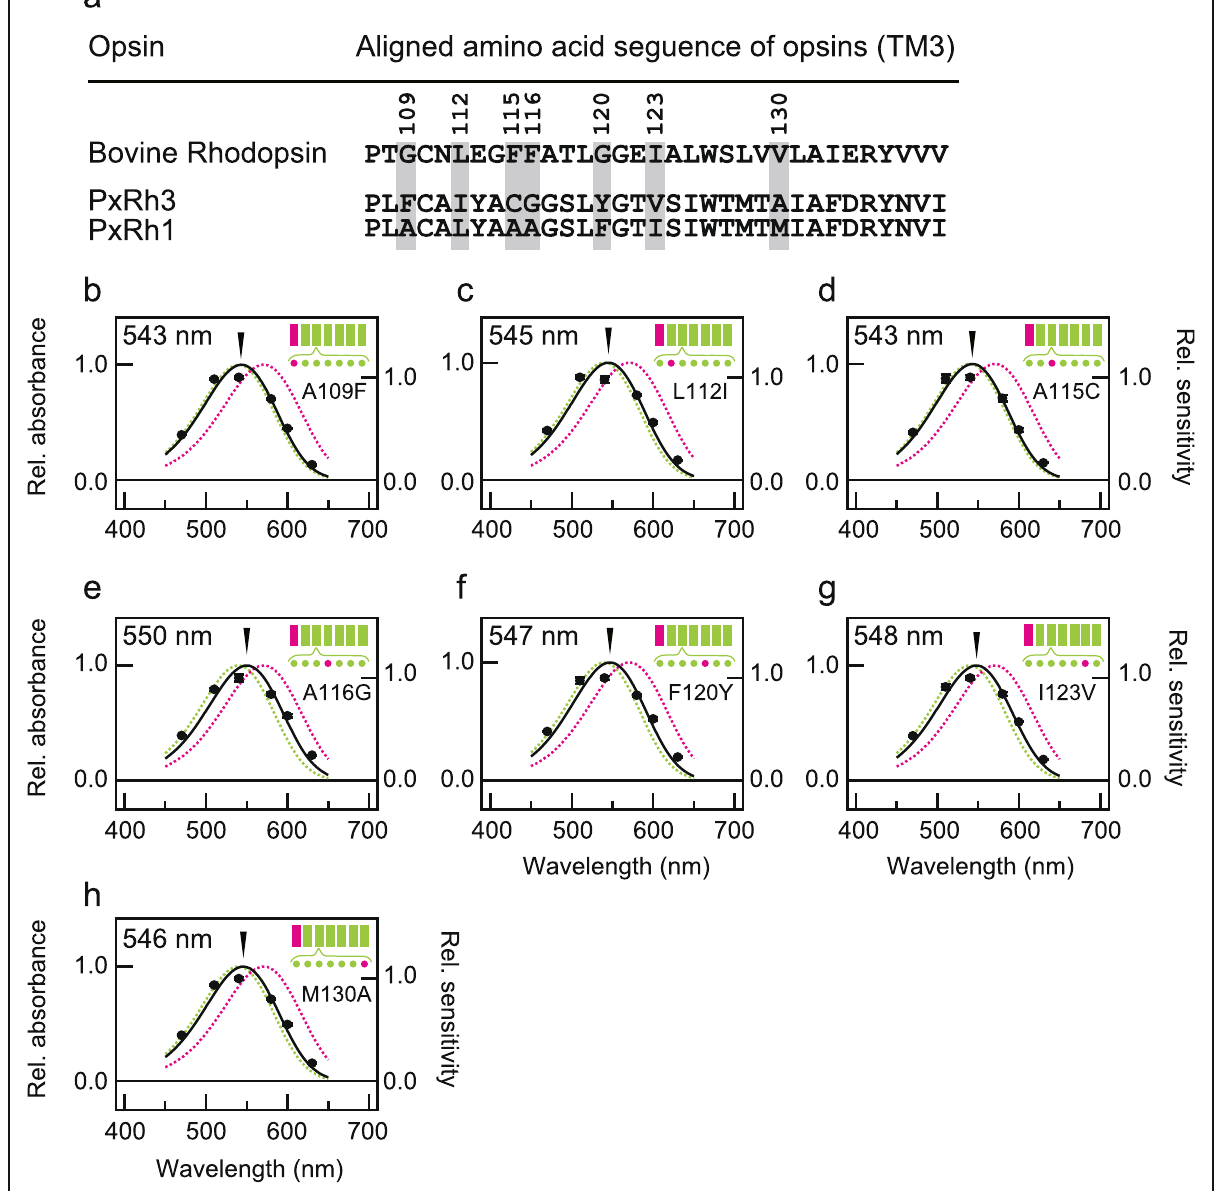
Fig. 5 Contribution of single mutations in helix III for the red-shift in a chimera Rh3(I)/Rh1(II-VII). The absorption spectra of chimeric mutants Rh3(I)/Rh1(II-VII) having a single mutation at positions in which amino acid residues are different between PxRh1 and PxRh3in helix III ( a , highlighted with grey boxes), Rh3(I)/Rh1(II-VII)_A109F ( b ), Rh3(I)/Rh1(II-VII)_L112I ( c ), Rh3(I)/Rh1(II-VII)_A115C ( d ), Rh3(I)/Rh1(II-VII)_A115G ( e ), Rh3(I)/ Rh1(II-VII)_F120Y ( f ), Rh3(I)/Rh1(II-VII)_I123V ( g ), Rh3(I)/Rh1(II-VII)_M130A ( h ) estimated by heterologous action spectroscopy. Solid circles represent the mean relative sensitivities of cultured cells expressing each chimeric mutant at each wavelength of light irradiation ( n = 3) and black curves indicate estimated absorption spectra. The error bar shows standard error. The absorption spectra of PxRh1_Gs and PxRh3_Gs are also indicated by green and magenta broken curves, respectively. Schematic drawings of seven transmembrane structures of butterfly opsins are also shown, in which helices and amino acid residues of PxRh1 and PxRh3 are indicated by green and magenta,